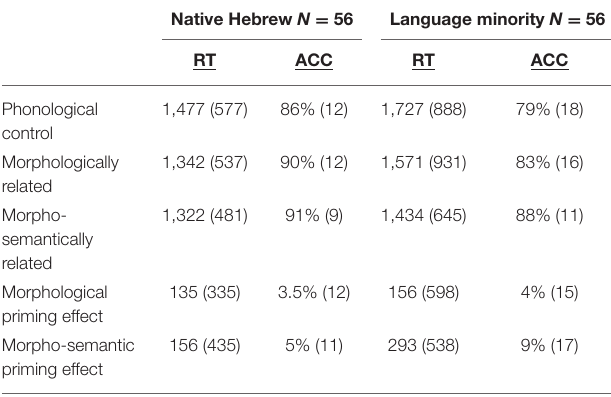
TABLE 6 | Average RTs in milliseconds ( SD ), and accuracy rates (%) in the cross-modal priming task, by